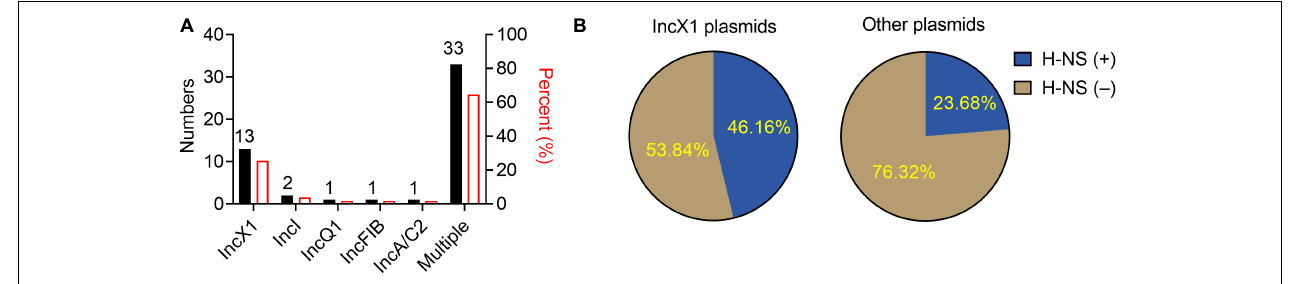
FIGURE 1 | IncX1 type is dominant in tet (X4)-bearing plasmids encoding H-NS from NCBI database. (A) The histogram shows plasmid typing and proportion of tet (X4)-positive plasmids from NCBI database. The black columns represent the numbers of tet (X4)-positive plasmids in different types. The red columns represent the corresponding percentage. (B) The left side of the pie graph shows the carrying rate of hns in tet (X4)-positive IncX1 plasmids. On the right is the carrying rate of hns gene in other types of plasmids.